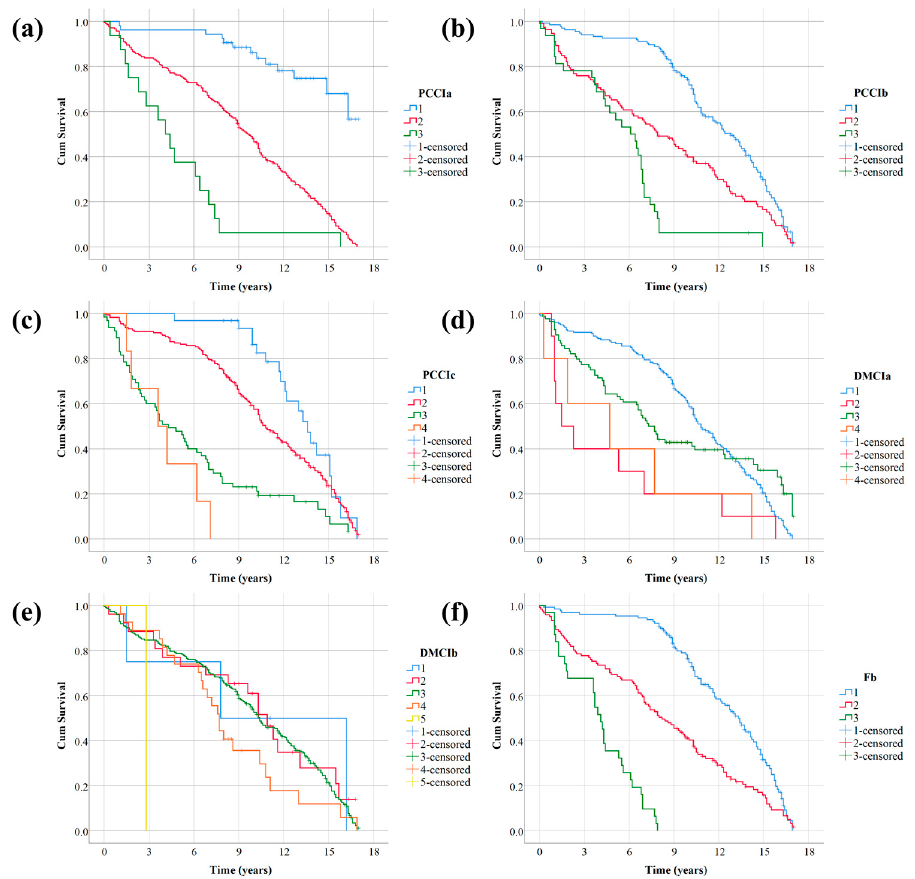
Figure 7. Univariate survival curve: ( a ) survival curve of PCCIa; ( b ) survival curve of PCCIb; ( c ) survival curve of PCCIc; ( d ) survival curve of DMCIa; ( e ) survival curve of DMCIb; ( f ) survival curve of Fb.